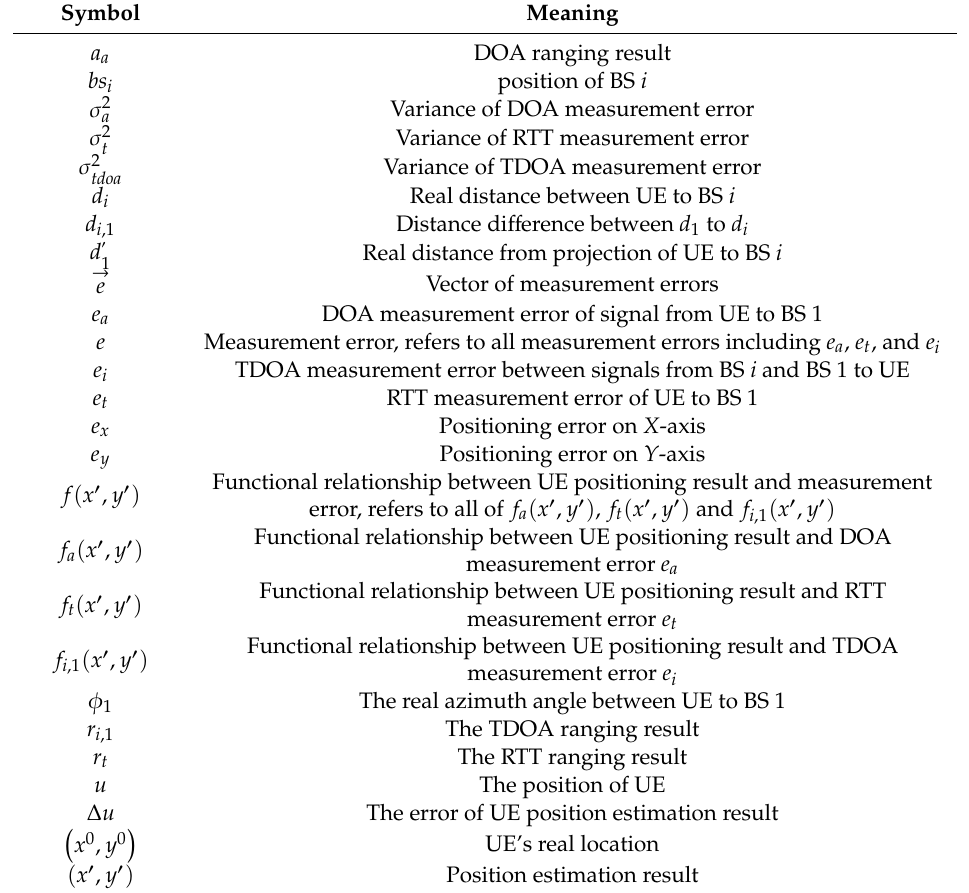
Table 1. List of